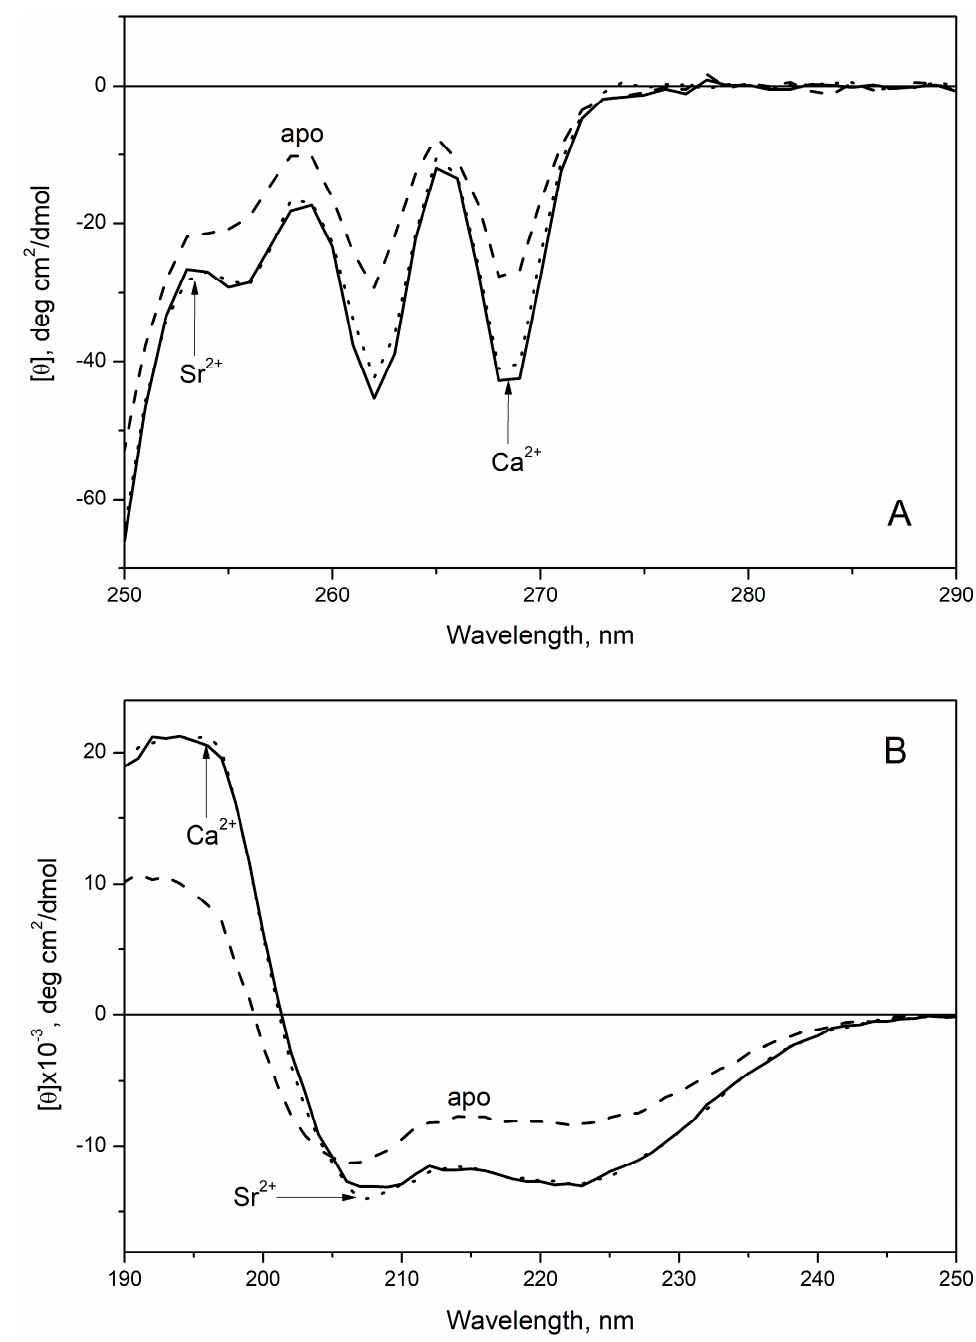
Figure 6. Near- ( A ) and far-UV ( B ) CD spectra for apo- and Sr 2+ /Ca 2+ -loaded states of rWT α -PA at 20 °C (10 mM H 3 BO 3 -KOH, pH 9.0, 1 mM EDTA or 1 mM SrCl 2 /CaCl 2 ). Protein concentration was 6.2–7.5 and 126–129 µM for far- and near-UV regions, respectively. Table 2. The secondary structure fractions estimated for rWT α -PA at 20 °C from the CD data shown in Figure 6, using CDPro software [31].